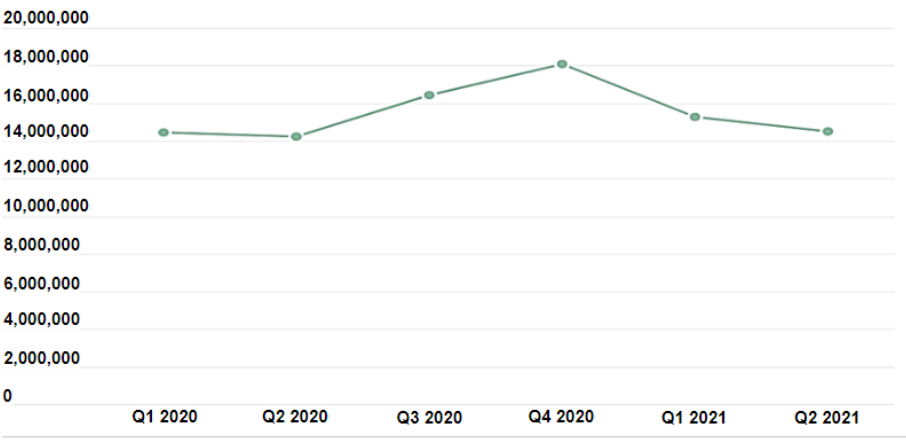
Figure 1. Number of cyberattacks against Kaspersky Android mobile solutions users 2020–2021 [5].